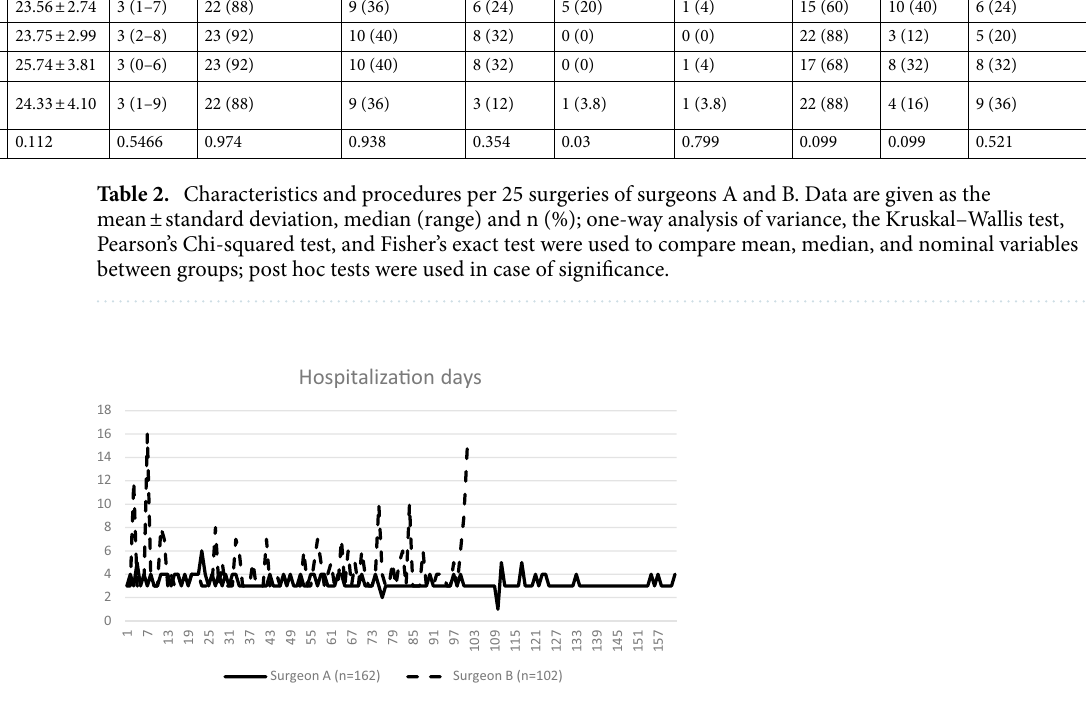
Figure 4. The postoperative hospitalization days. The x-axis indicates the number of procedures performed. The y-axis indicates the postoperative hospitalization time (days). The solid line shows surgeon A’s series: vaginal pelvic reconstruction without mesh. The dotted line shows surgeon B’s series: vaginal pelvic reconstruction with mesh. The solid line ends at procedure No. 162, and the dotted line ends at procedure No.